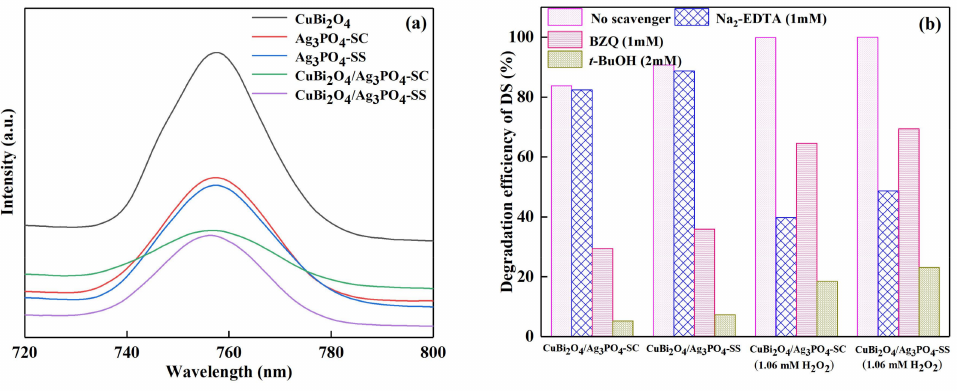
Figure 7. ( a ) Photoluminescence (PL) emission spectra of the as-prepared catalysts; ( b ) degradation efficiency of DS over different catalyst systems in the presence of